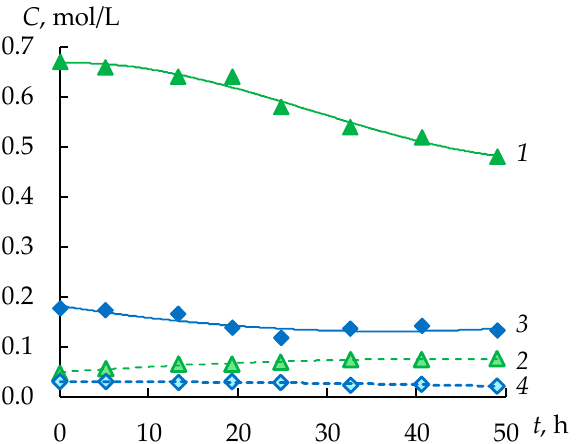
Figure 8. Concentrations of FeSO 4 (1, 2) and CuSO 4 (3, 4) in the feed (1, 3) and concentrate (2, 4) tanks during the second stage.